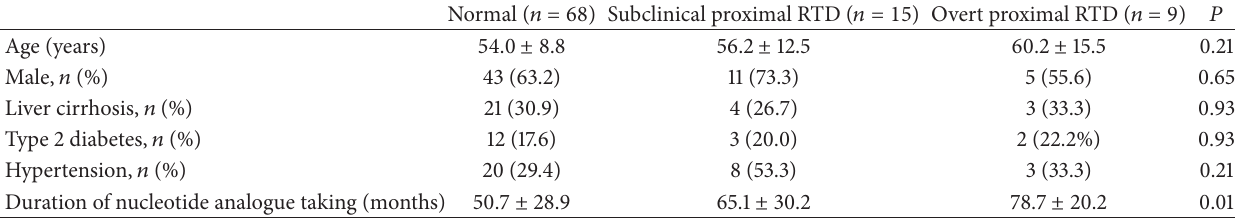
Table 1: Demographics of 92 patients on nucleotide analogues according to the severity of proximal renal tubular dysfunction